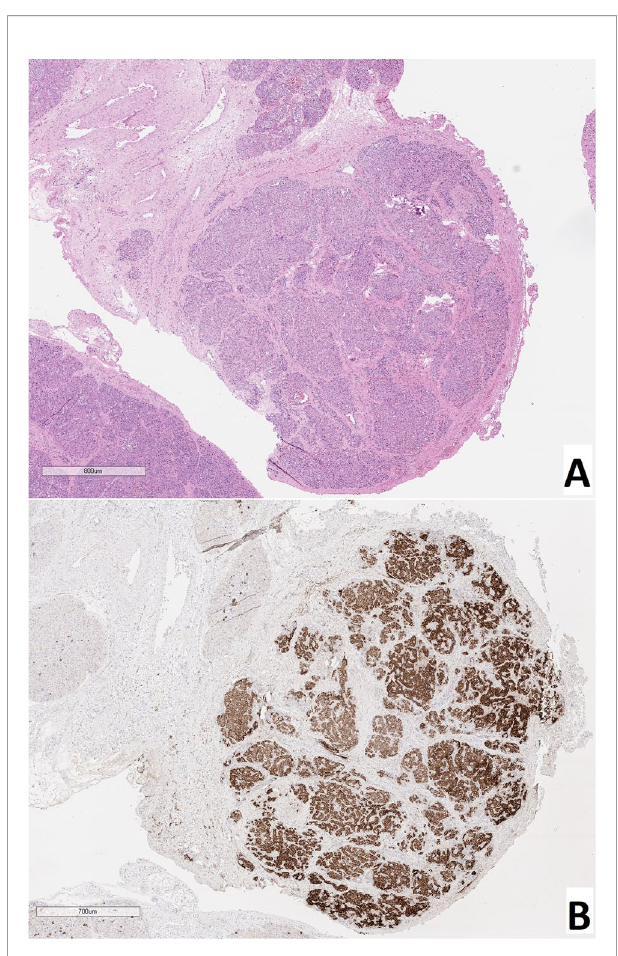
FIGURE 6 | True adenoma in the pancreas of a patient with a focal form of congenital hyperinsulinism. (A) – hematoxylin and eosin staining, (B) –